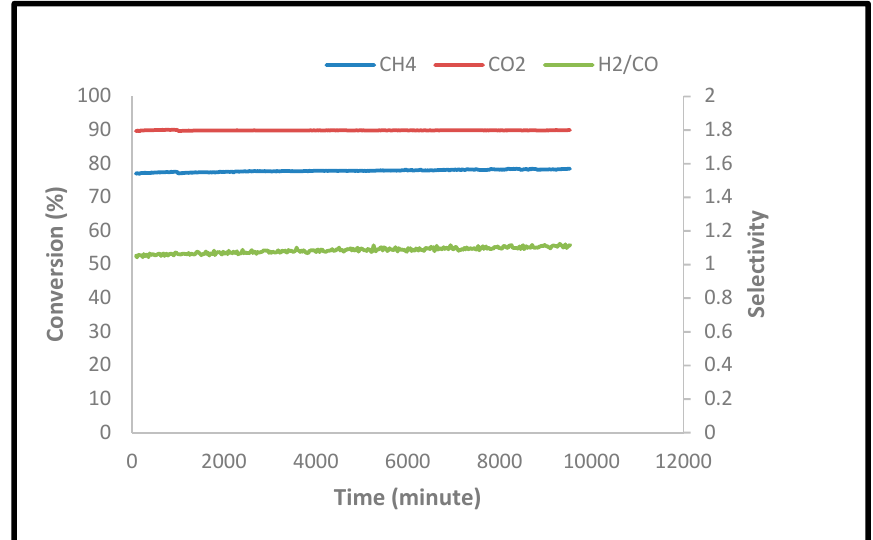
Figure 11. Ni,Pd,Pt / Mg 0.85 Ce 4 + 0.15 O catalysts stability tests with a temperature of 900 ◦ C, GHSV = Figure 11. Ni,Pd,Pt/Mg 0.85 Ce 4+0.15 O catalysts stability tests with a temperature of 900 °C, GHSV = 15,000 15,000 mL h − 1 g − 1 cat., and CH 4 / CO 2 ratio of 1:1. atmospheric pressure, for 200 h. mL h − 1 g − 1 cat., and CH 4 /CO 2 ratio of 1:1. atmospheric pressure, for 200 h.